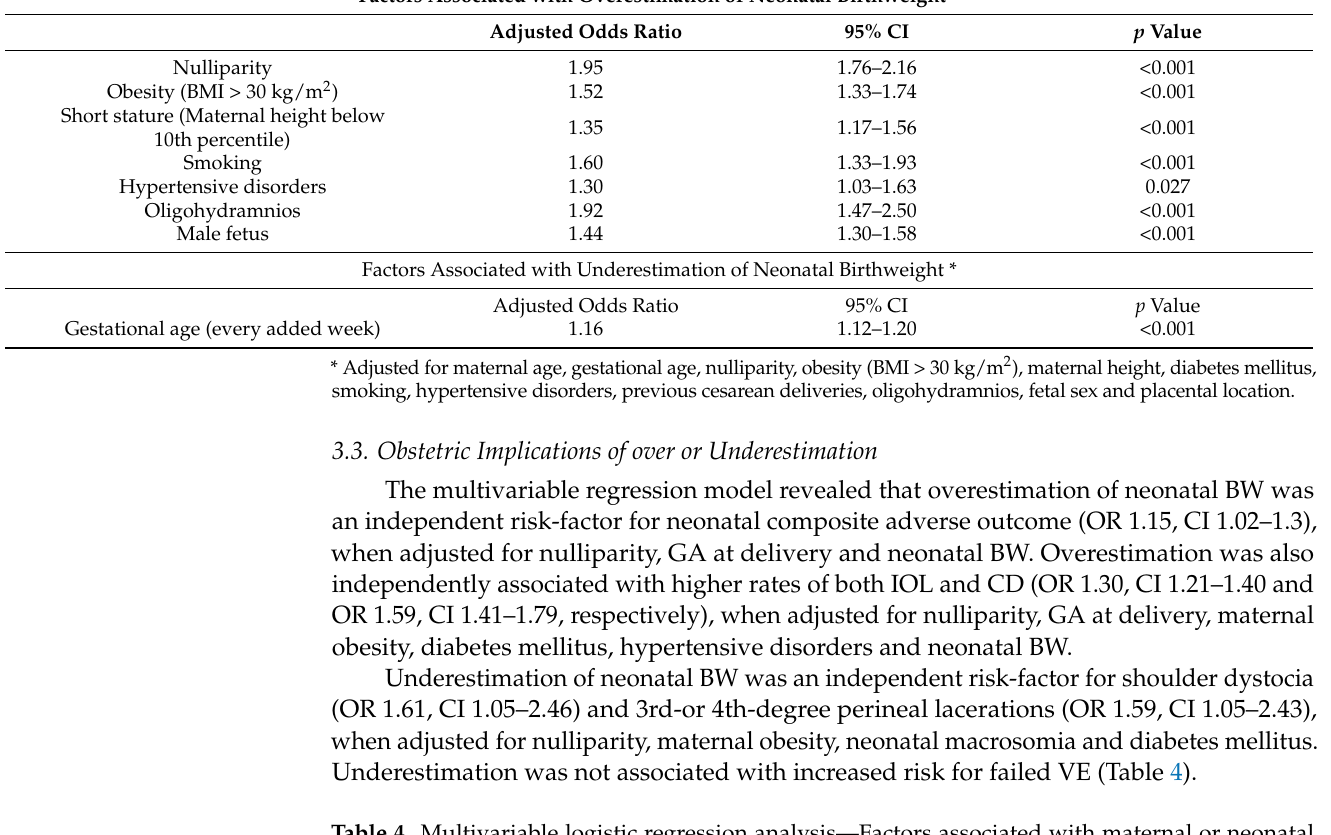
Table 4. Multivariable logistic regression analysis—Factors associated with maternal or neonatal adverse